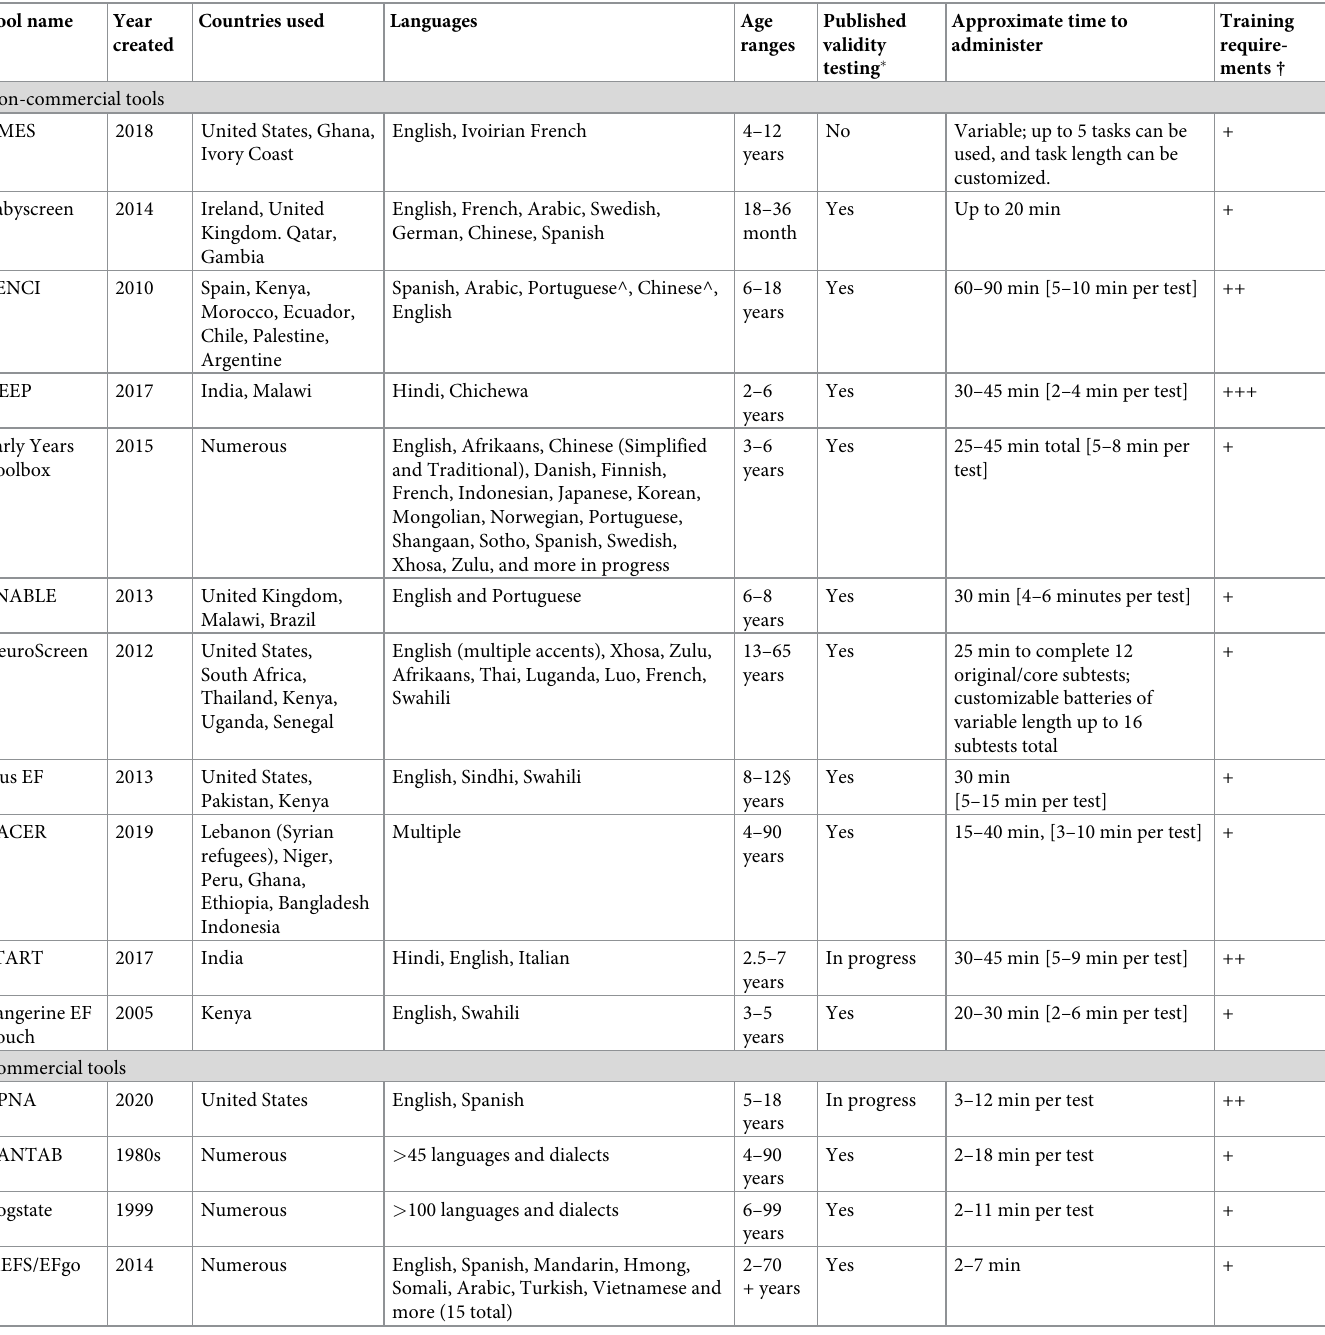
Table 1. Characteristics of tablet-based cognitive